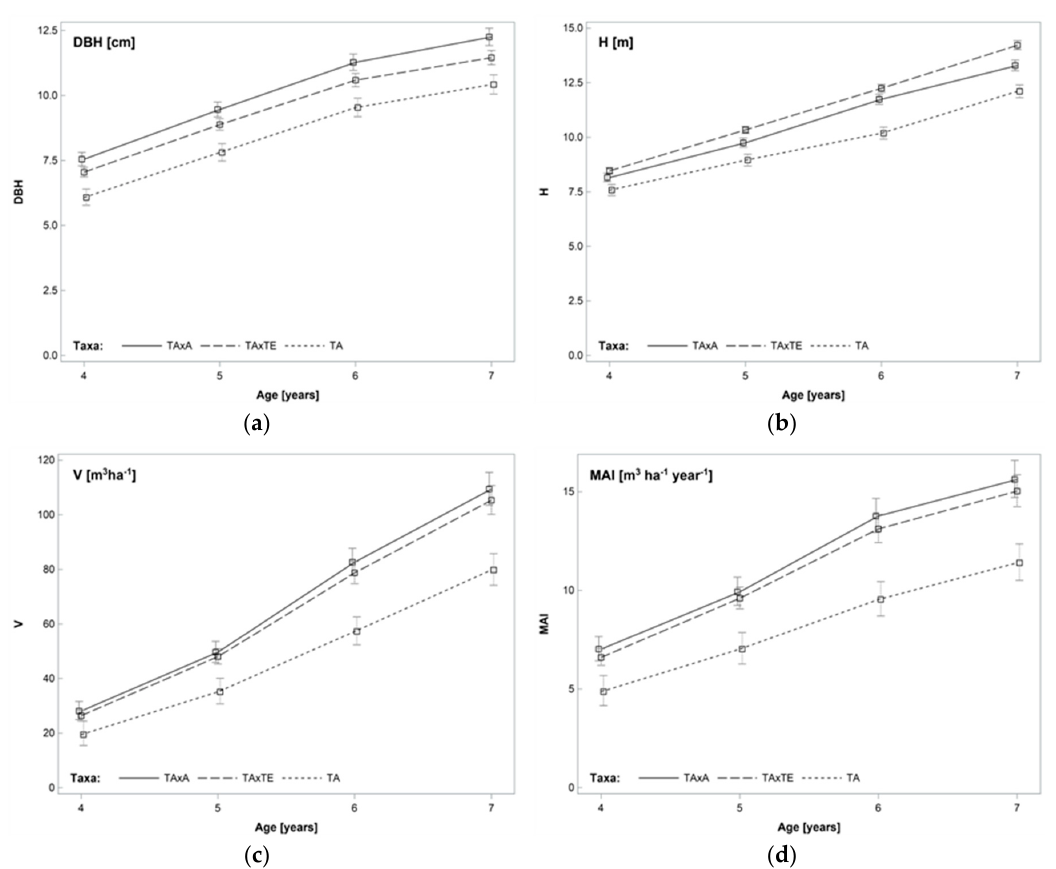
Figure 3. Trend lines of ( a ) mean diameter at breast height (DBH), ( b ) height (H), ( c ) stem volume (V ha − 1 ) and ( d ) mean annual increment (MAI)) for taxa over time. Vertical bars denote standard errors. Abbreviations: TA: P. tremula L . ; TA × A: P. tremula × P. alba ; TA × TE: P. tremula × P. tremuloides.